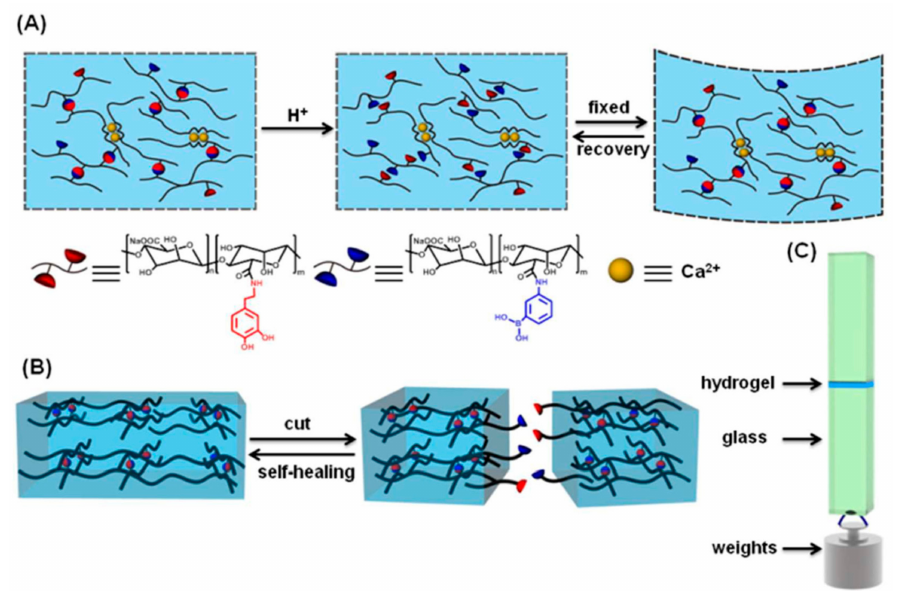
Figure 10. Schematic illustration of ( A ) shape memory, ( B ) self-healing, and ( C ) adhesion properties of phenylboronic acid-dopamine-grafted (PBA-DA) hydrogels. Reproduced with permission from Ref. [89], Copyright 2016, Royal Society